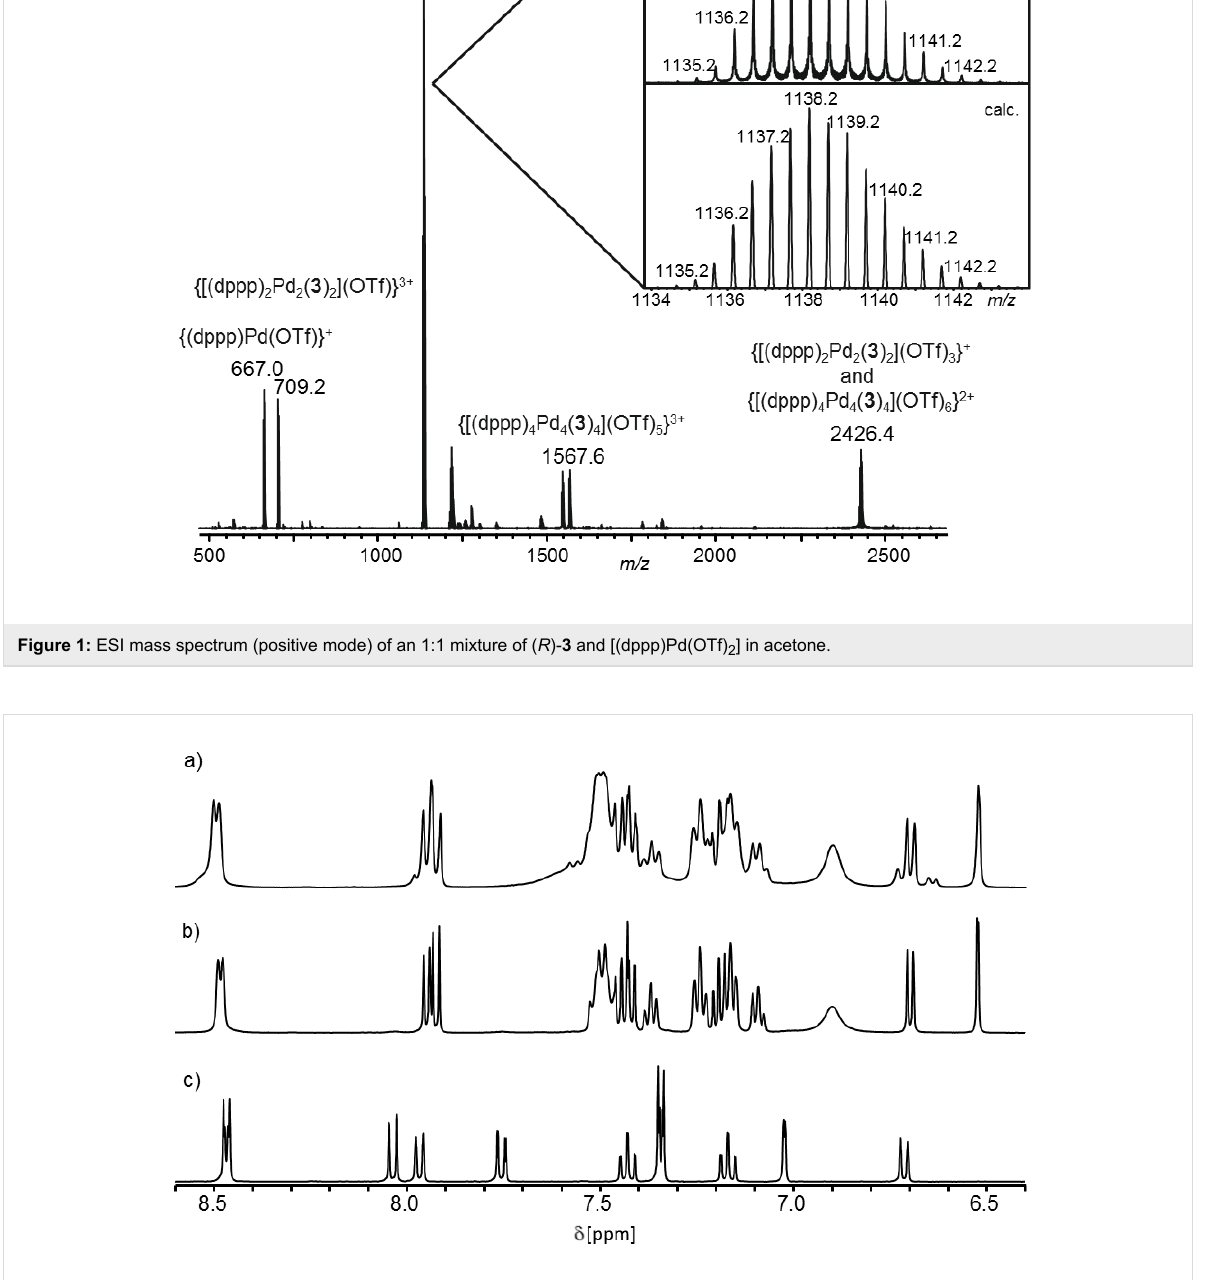
Figure 2: 1 H NMR spectra (500.1 MHz, in CD 2 Cl 2 /CD 3 CN 3:1 at 298 K) of a) a 1:1 mixture of [Pd(dppp)]OTf 2 and ( rac )- 3 , b) a 1:1 mixture of [Pd(dppp)]OTf 2 and ( R )- 3 , and c) ( R )- 3